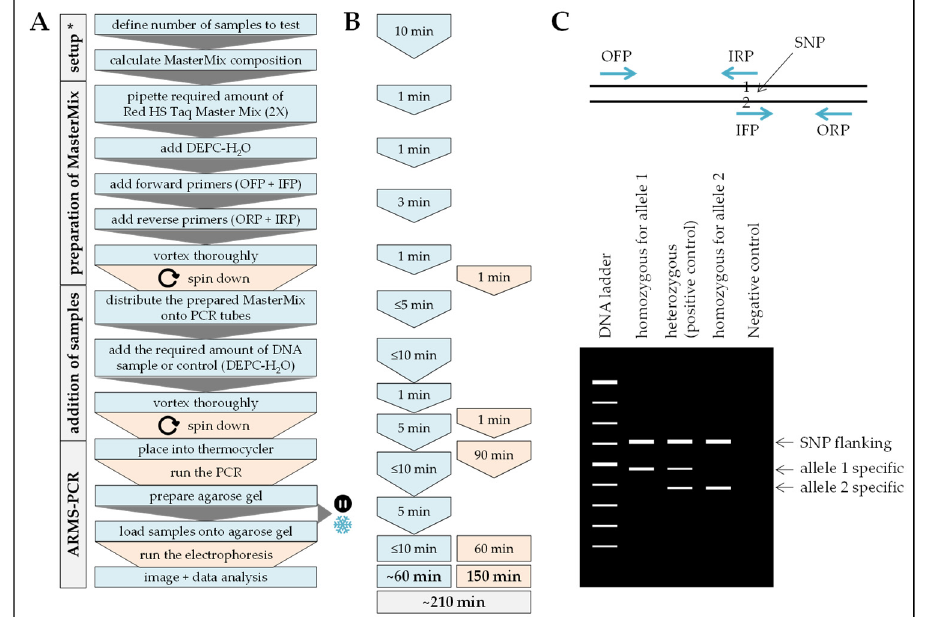
Figure 4. Workflow, timing, and expected results for the analysis of SNPs using the ARMS-PCR method. In ( A ) workflow and ( B ) timing the blue color marks handling steps (time) of the experimenter and the orange color marks pause times caused by the procedure. ( C ) Expected results: All PCR products should have the largest size band defined by the two outer primers (OFP and ORP). Homozygous samples should show only one additional band—their length is defined by the allele specific inner primers. Heterozygous samples should show both additional bands. * When the method is frequently done a calculation matrix should be used.